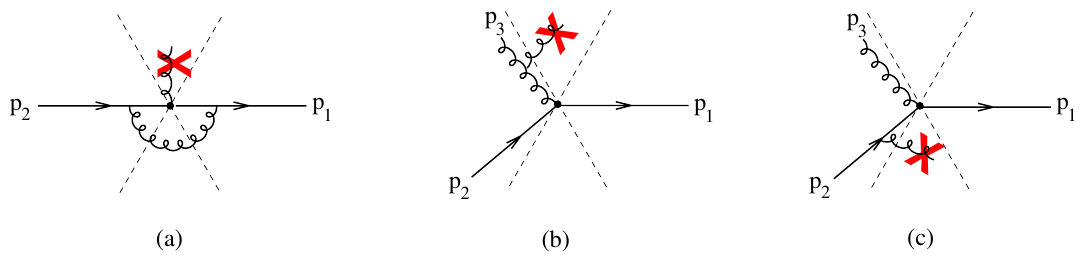
Figure 4 . Representative configurations corresponding to a soft gluon emitted from hard O ( α s ) configurations. The red cross corresponds to the constraint − Θ( v ( k ) − v ) on soft gluon k .